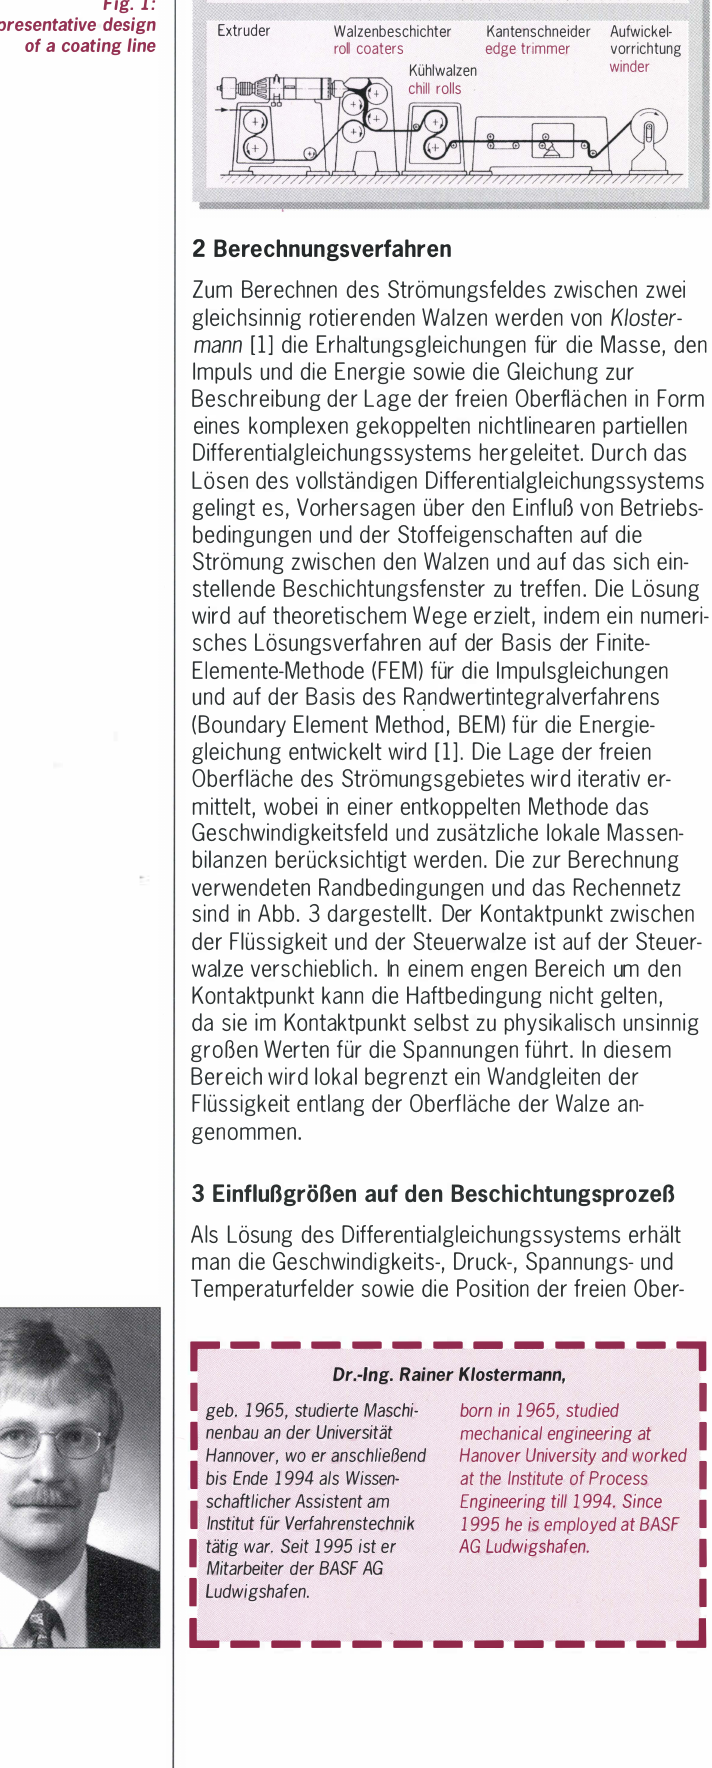
Fig. 1: Representative